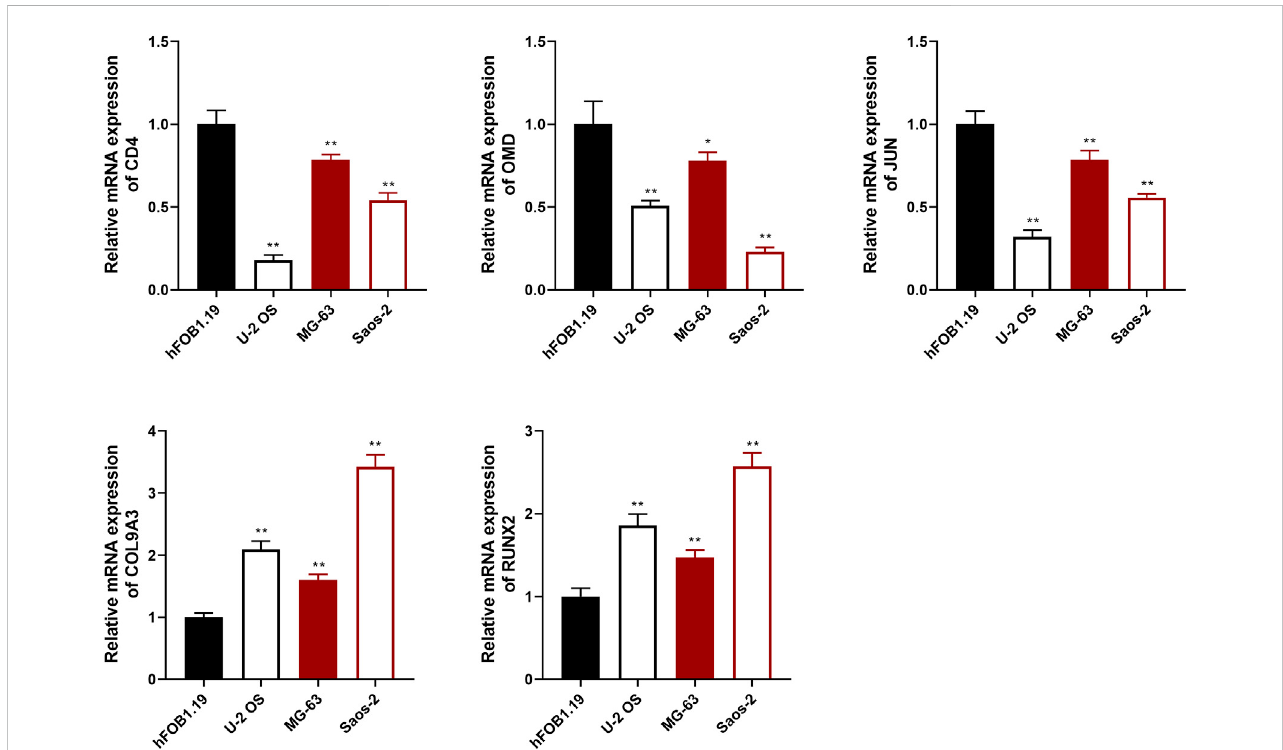
FIGURE 9 The relative expression of CD4, OMD, JUN, COL9A3, and RUNX2 was detected using qRT-PCR assay. * p < .05 and ** p < .01 compared with the hFOB1.19